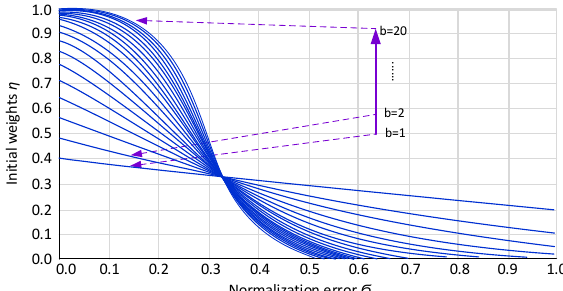
Figure 6. The relationship between normalized error and initial weight for different b values. The variation curve of the evaluation function g ( b ) with b is shown in Figure 7. It can be seen that when b = 5, the evaluation function g ( b ) takes the minimum value. Therefore, we chose b = 5 as the optimal value of b .